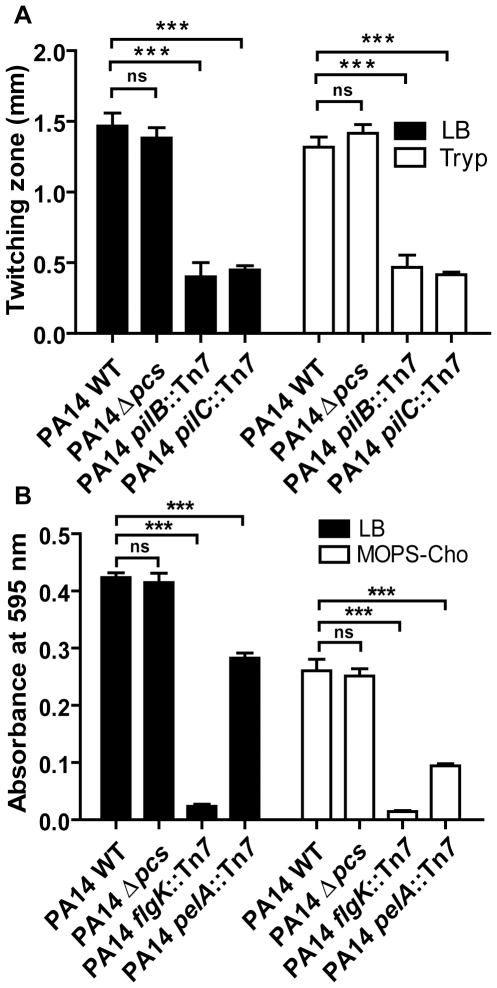
PC-deficient mutants are not affected for motility and biofilm formation on abiotic surfaces.(A) Twitching motility assays of PA14 strains on LB and tryptone agar plates were performed as previously described [28]. Motility was determined by measuring diameter (mm) of the zone of expansion from the point of inoculation. (B) Biofilm assays of PA14 strains grown in LB and MOPS-20mM choline media were performed using 96-well PVC microtiter plates as previously described [28]. At 12 hours, the biofilms formed were stained with crystal violet, solubilized with 95% ethanol, and quantified by measuring absorbance at 595 nm. In panels A and B, values represent averages and error bars are SD (n = 3). Tests of significance were conducted using a one- way analysis of variance (ANOVA) with a Bonferroni multiple comparison test, ***P<0.001, ns
P>0.05.